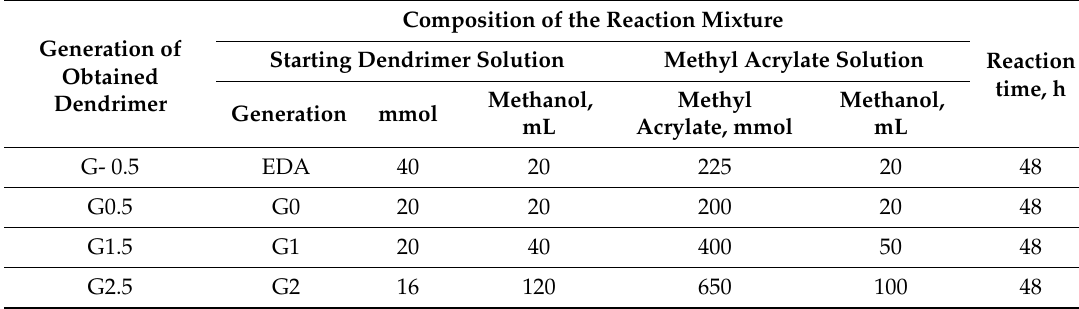
Table 1. Synthesis of ester-terminated PAMAM dendrimers.